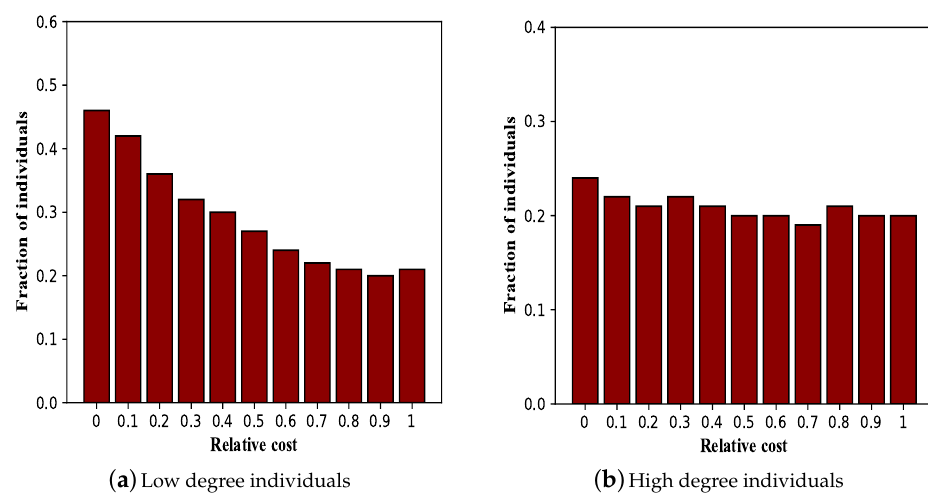
Figure 10. The nodes are sorted in descending order of degree. The top 100 nodes are the top 10%, and the bottom 100 nodes are the last 10%. With the increase of the relative cost, the collectivist strategy of individuals with low degree is declining. However, the proportion of collectivist strategy of individuals with high degree has been kept at around